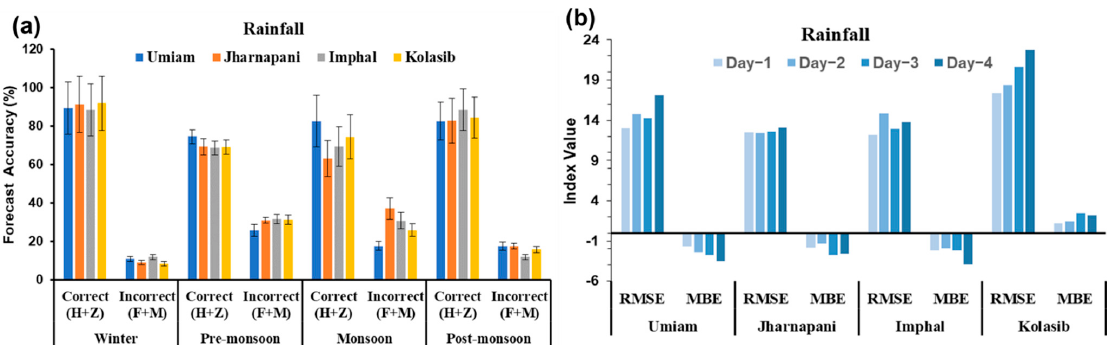
Figure 1. Evaluation of rainfall forecast based on the accuracy ( a ) and statistical parameters ( b ) over distinct locations of the northeastern hill region of India.